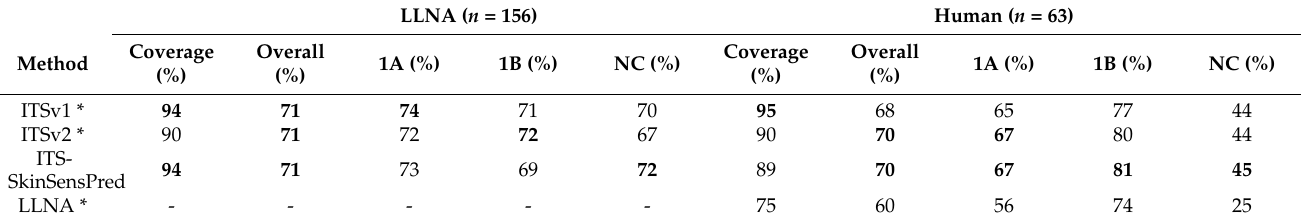
Table 2. Correct classification rate of potency classification for LLNA data and human